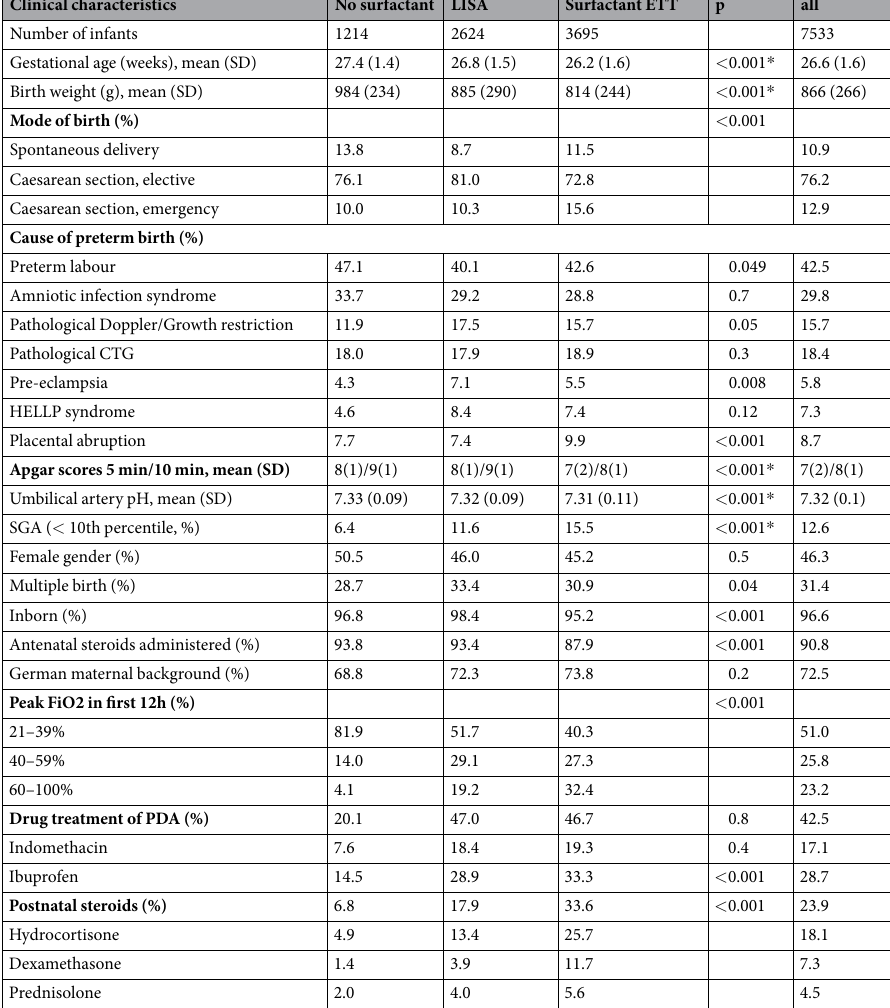
Table 1. Clinical characteristics of the study population according to respiratory management/surfactant administration. p-values (LISA vs. Surfactant ETT) are derived from Pearson-chi 2 test or Mann-Whitney-U-test if indicated ( *